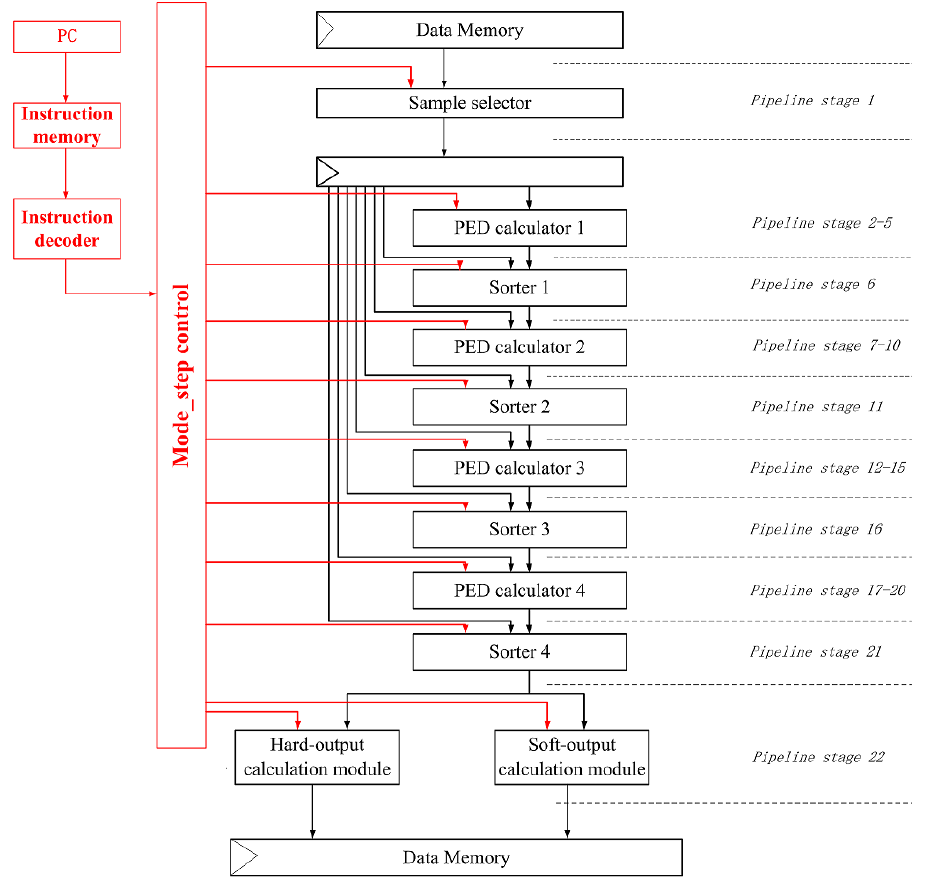
Figure 10. Top-level architecture pipeline